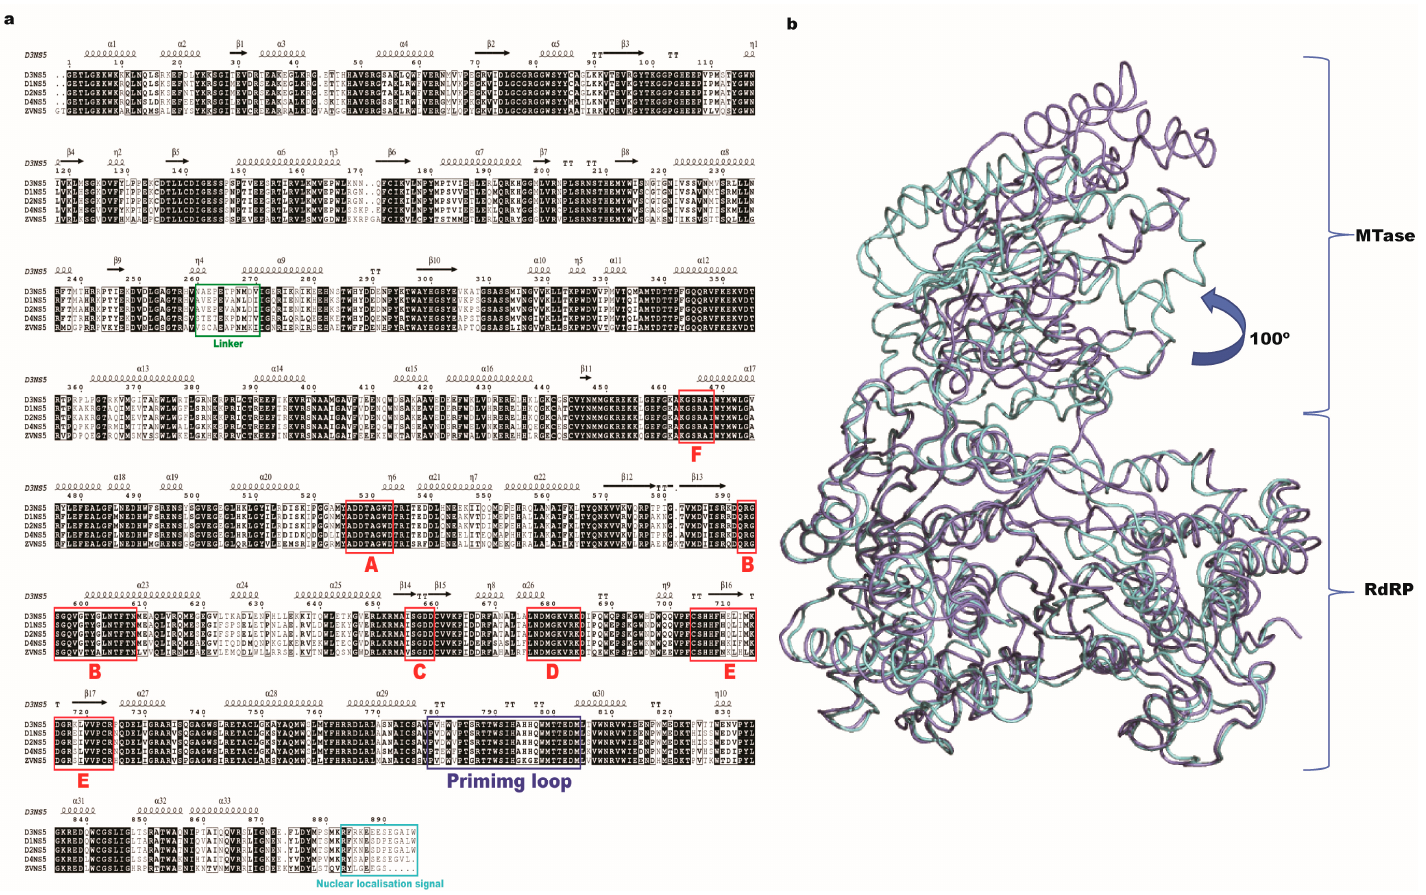
Figure 1. ( a ) Sequence alignment of dengue virus (DENV) NS5 proteins from the four serotypes. Sequence numbering is according to DENV2 NS5. Secondary structure assignment follows the DENV3 NS5 full-length protein structure (Protein Data Bank (PDB) access code 4V0Q). Specific sequence motifs (A–F) are labeled in red. The linker region is indicated in green. The recently characterized nuclear localization signal is colored in light blue and the priming loop in blue; ( b ) Superimposition between DENV 3 NS5 (4V0Q, light blue) and Zika virus (ZIKV) NS5 (5TFR, purple) full-length protein structure is represented as α -carbon traces. MTase: methyltransferase; RdRP: RNA ‐ dependent RNA polymerase.